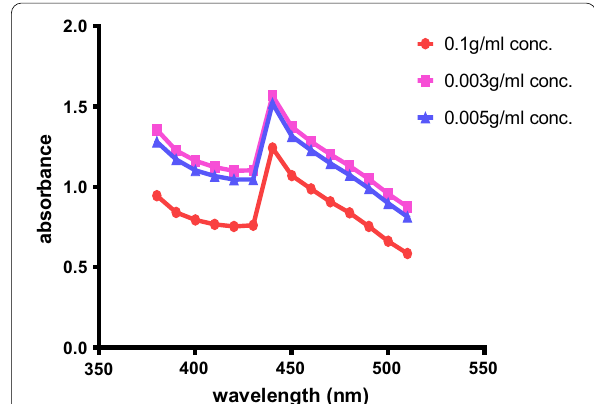
Fig. 3 Graph of UV–Vis spectrum of the M. charantia silver nanoparticles